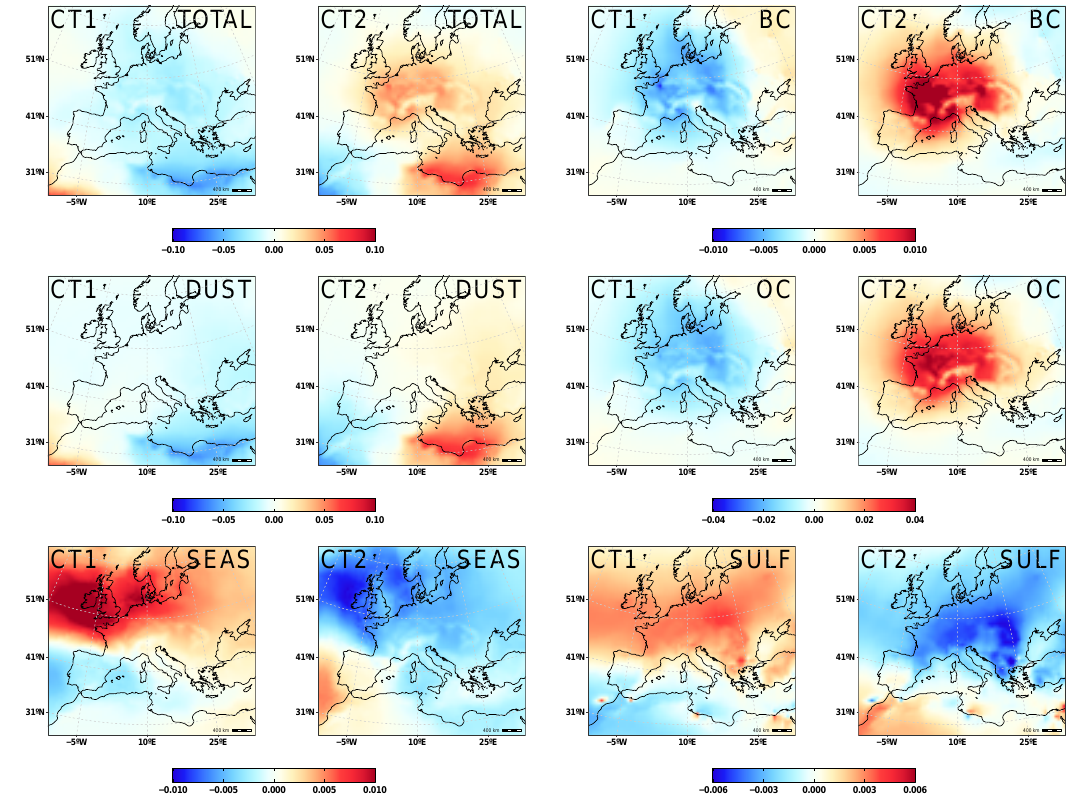
Figure 3. AOD anomalies in CT1 and CT2 in ARCI experiments, computed considering all types of aerosols (TOTAL, top left ) and by species. The species of aerosols involved are black carbon (BC; top right ), dust ( center left ), organic carbon (OC; center right ), sea salt (SEAS; bottom left ) and sulfates (SULF; bottom right